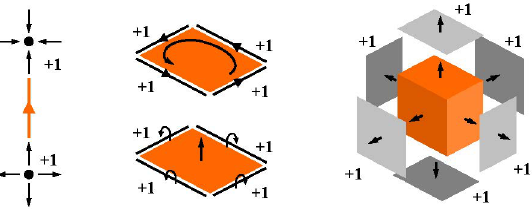
Figure 51: Examples of incidence numbers equal to +